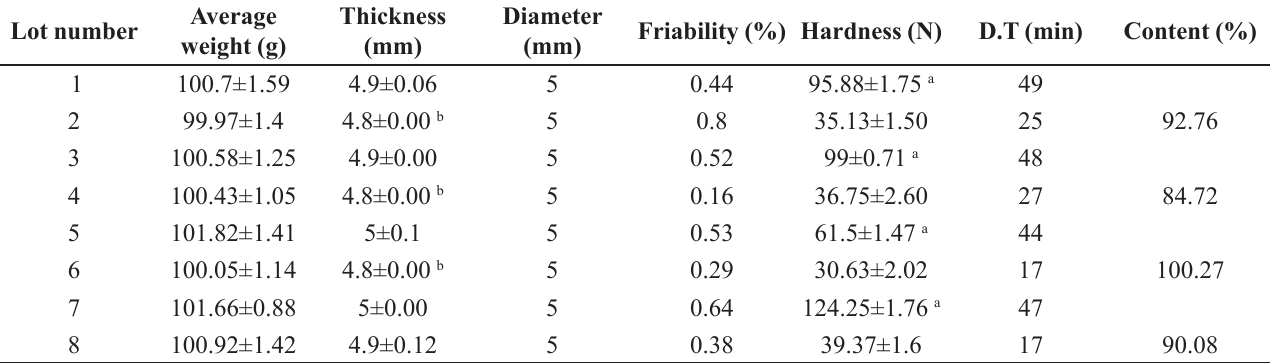
TABLE III - Result of quality control analyzes for developed tablets. ANOVA followed by Tukey post-test: a: significantly higher in relation to the groups whose babassu comprised the formulation (p<0.01); b: significantly less than lots 5 and 7, (p<0.05). D.T: Disintegration time; Content: content of marker naringenin Lot